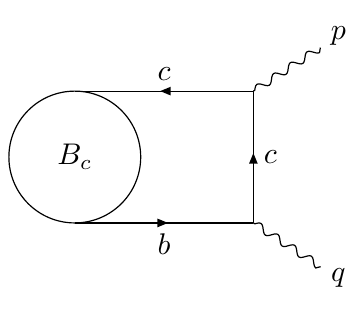
Figure 1 . The leading order diagram representing the correlation function